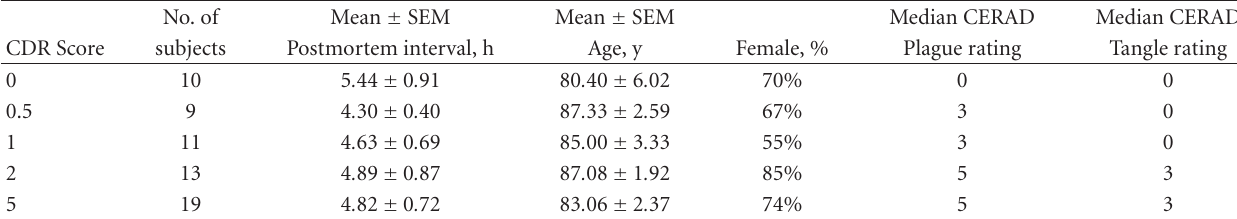
Table 1: Characteristics of study subjects 1